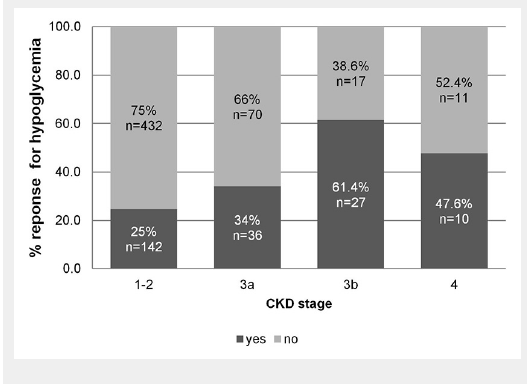
Figure 4 Presence of hypoglycaemia and chronic kidney disease (CKD) stage.